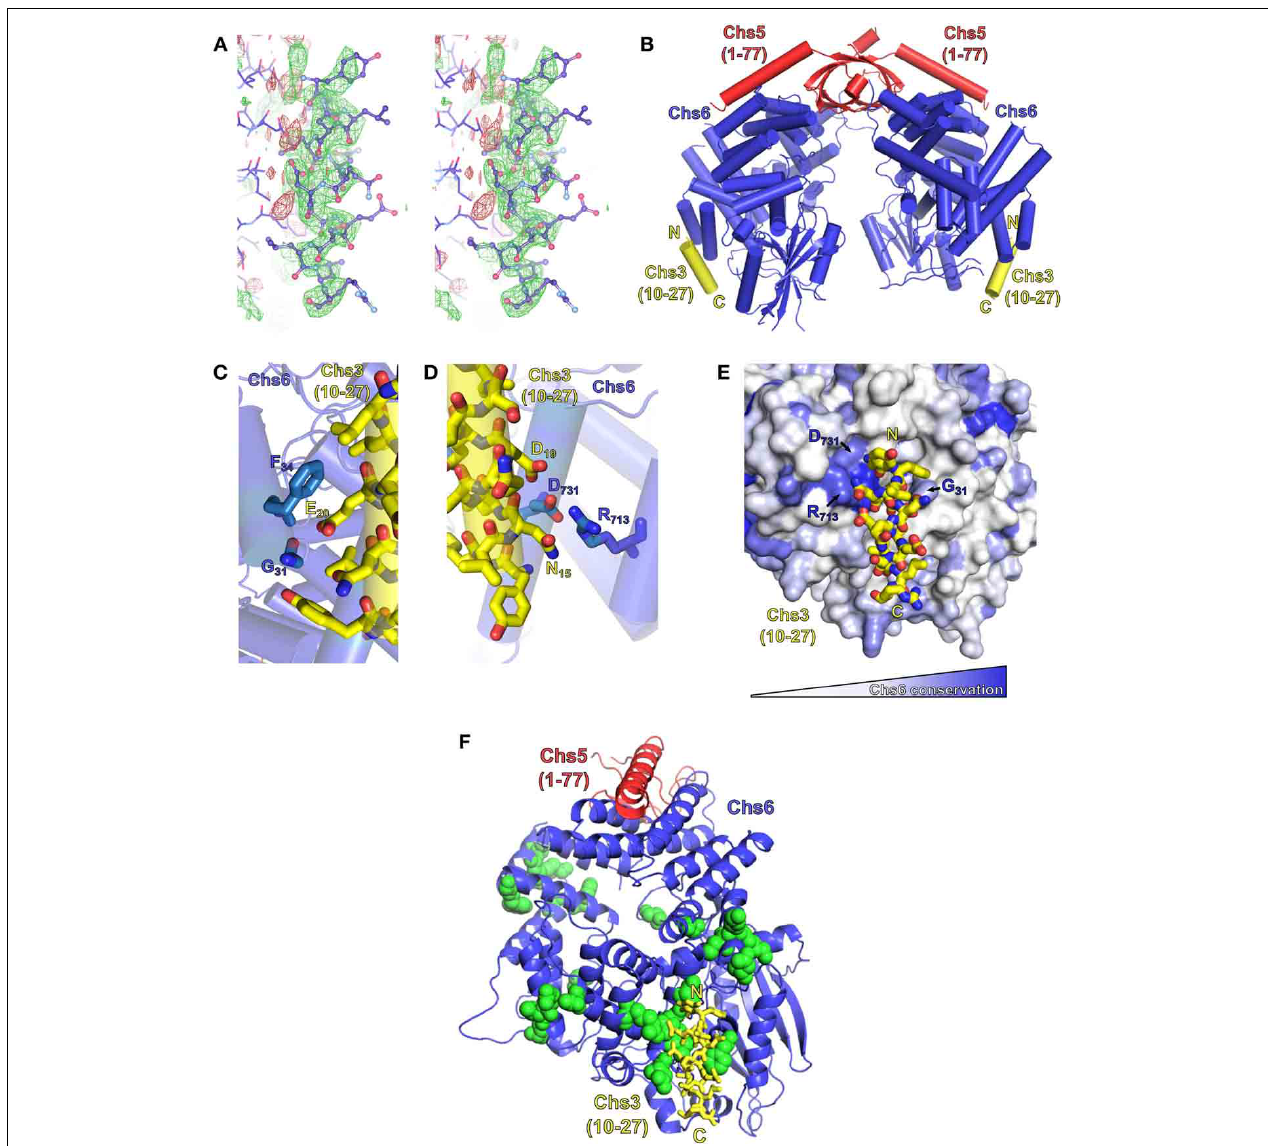
FIGURE 6 | Exomer co-crystalizes with Chs3 residues 10–27. (A) Stereo image (wall-eyed) of the original F o -F c difference map calculated after molecular replacement, used to model the Chs3 peptide (shown as ball-and-stick model), contoured at + 2.5 σ (green) and − 2.5 σ (red). The negative density to the left of the peptide is assumed to be due to series truncation errors arising from the modest resolution of the data. (B) Model of an exomer complex containing Chs5(1–77) (red), Chs6-6xHis (blue) and a peptide of Chs3 residues 10–27 (yellow, only residues 12–25 are visible).